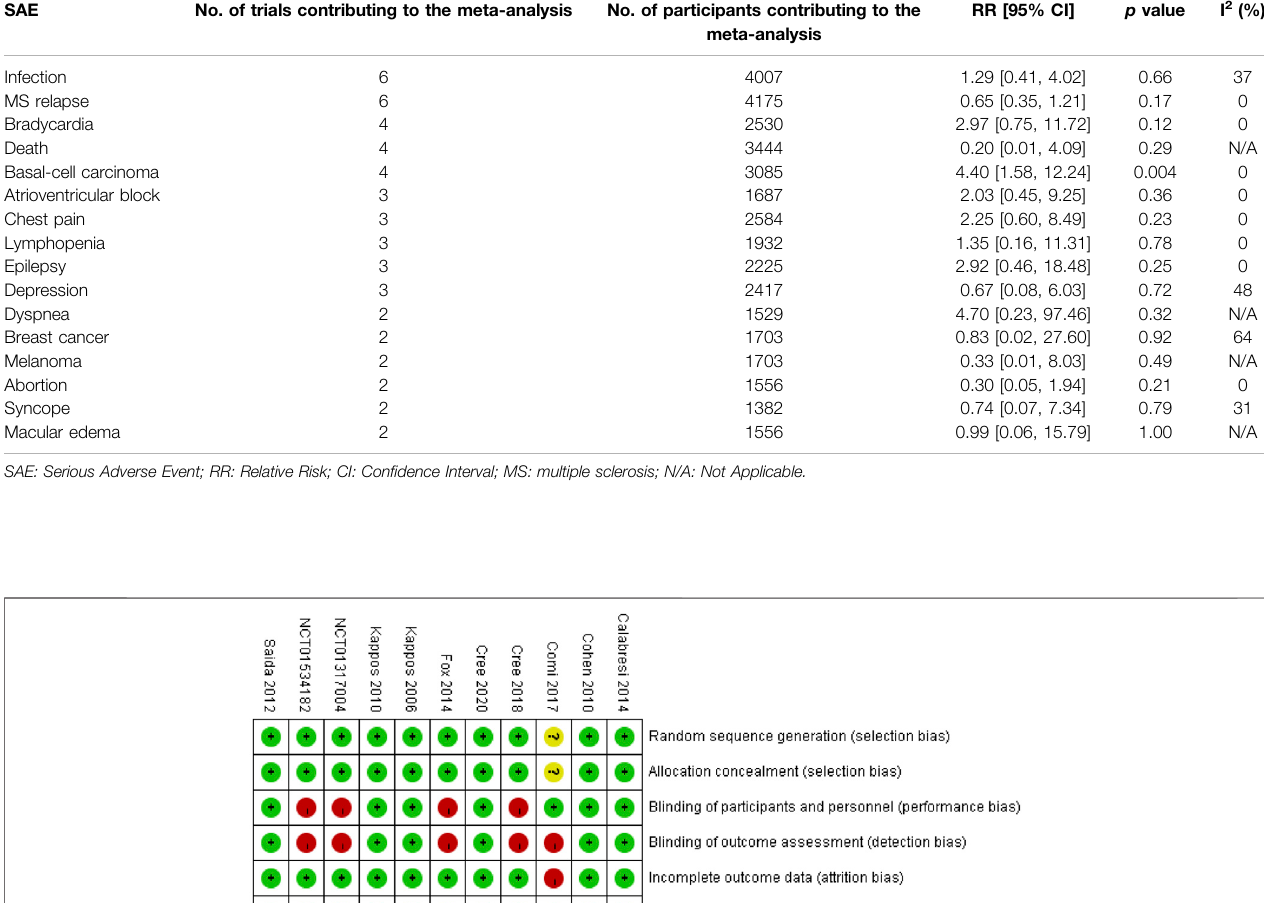
TABLE 4 | Meta-analysis of SAEs between fi ngolimod 0.5 mg/d and placebo or DMTs groups; from all trials using random effects models, where at least twotrialsprovided data that could be included. SAE No. of trials contributing to the meta-analysis No. of participants contributing to the